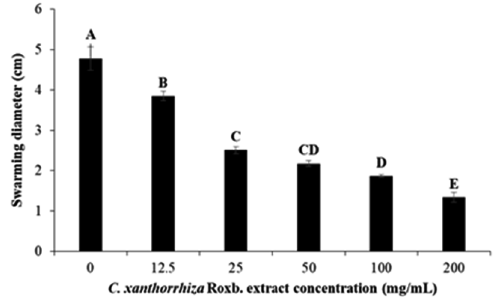
Fig. 2. Effect of the Curcuma xanthorrhiza Roxb. extract (0 - 200 mg/mL) on the P. aeruginosa swarming motility. The reduction of swarming diameter (cm) when added with C. xanthorrhiza Roxb. extract. The alphabetical grouping represent the significance different between extract concentration (Those that share similar letter is not significant